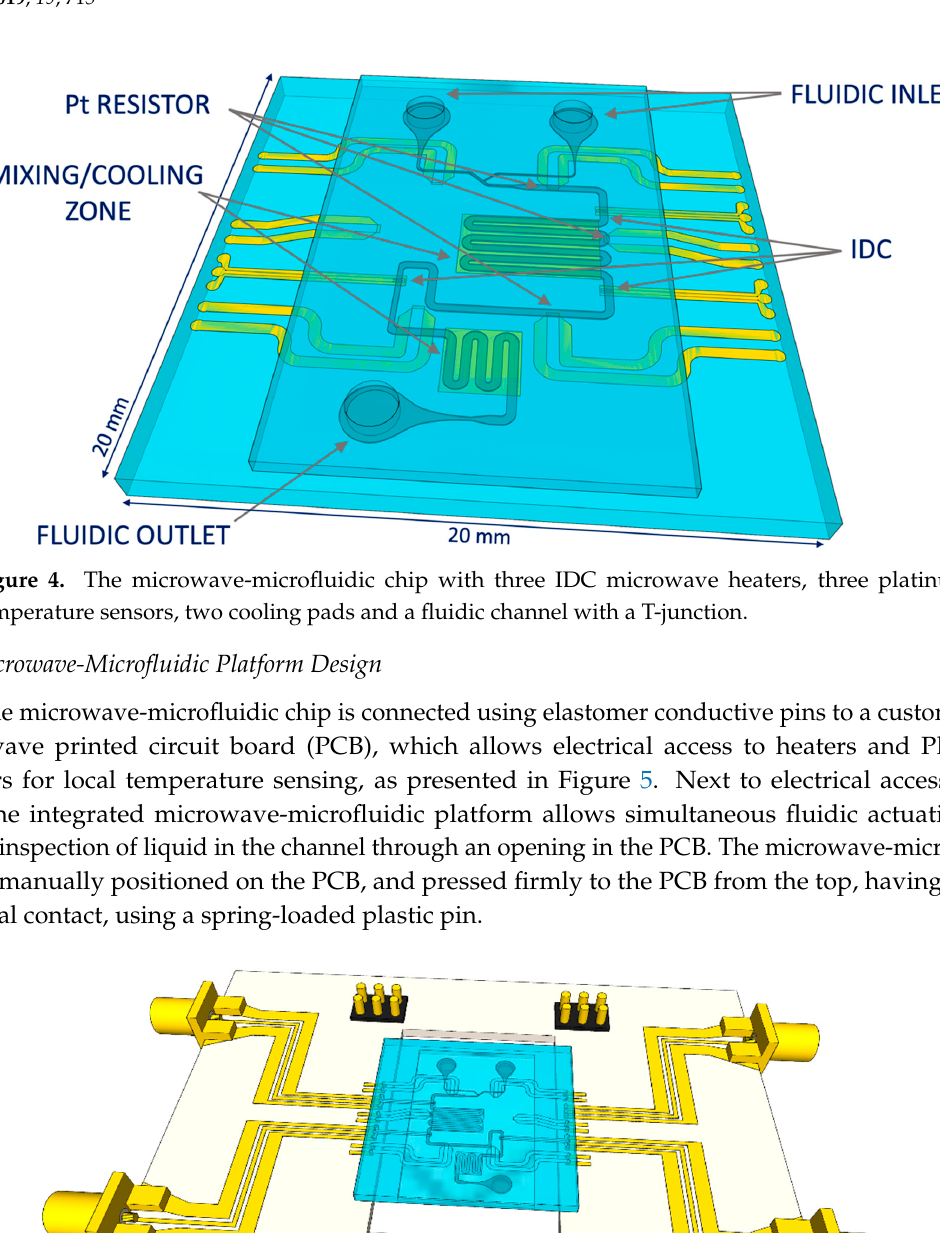
Figure 5. Illustration of the microwave-microfluidic platform with the microwave-microwave chip.